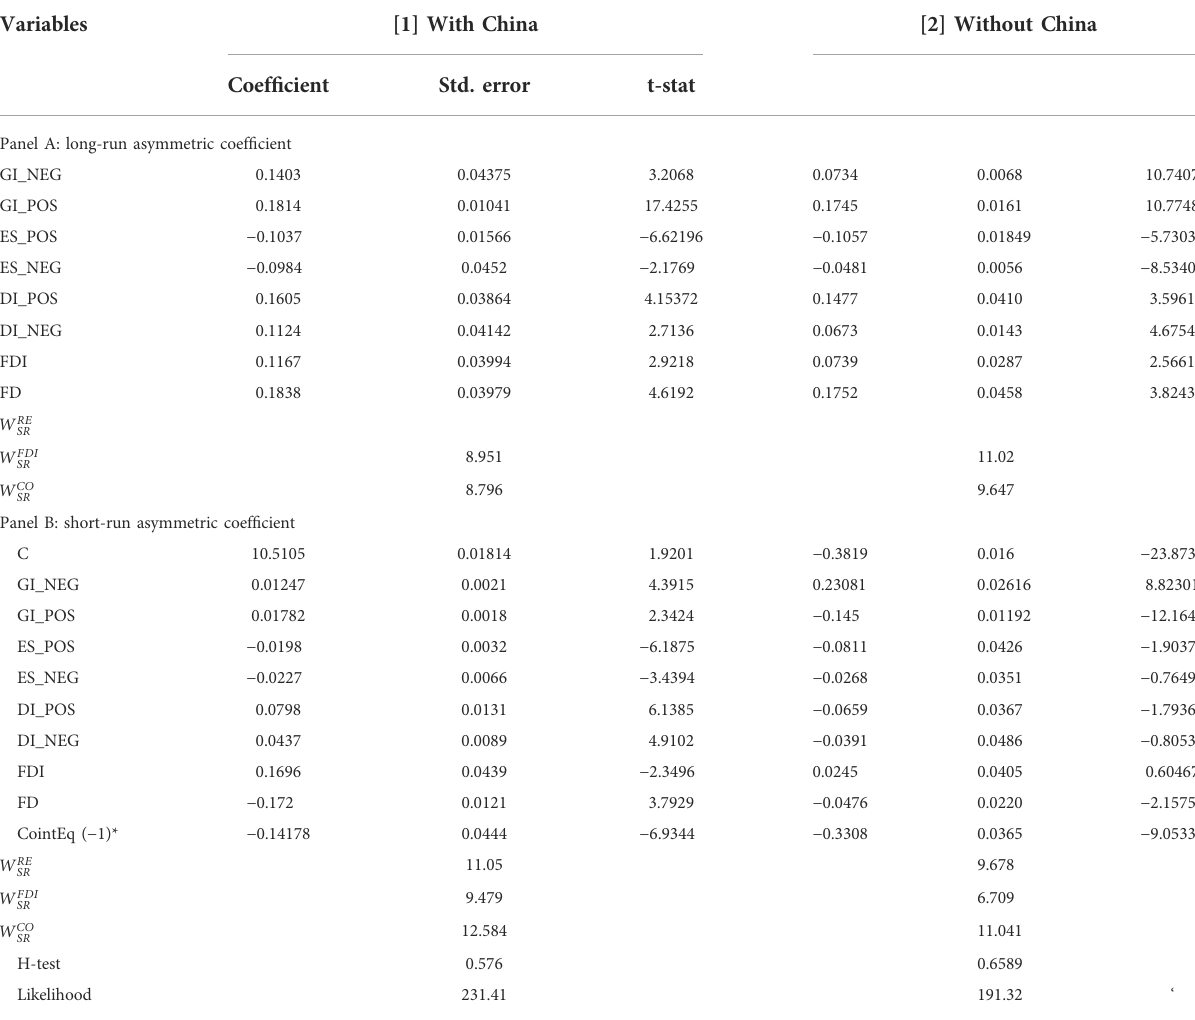
TABLE 7 Result of nonlinear long-run and short-run assessment.